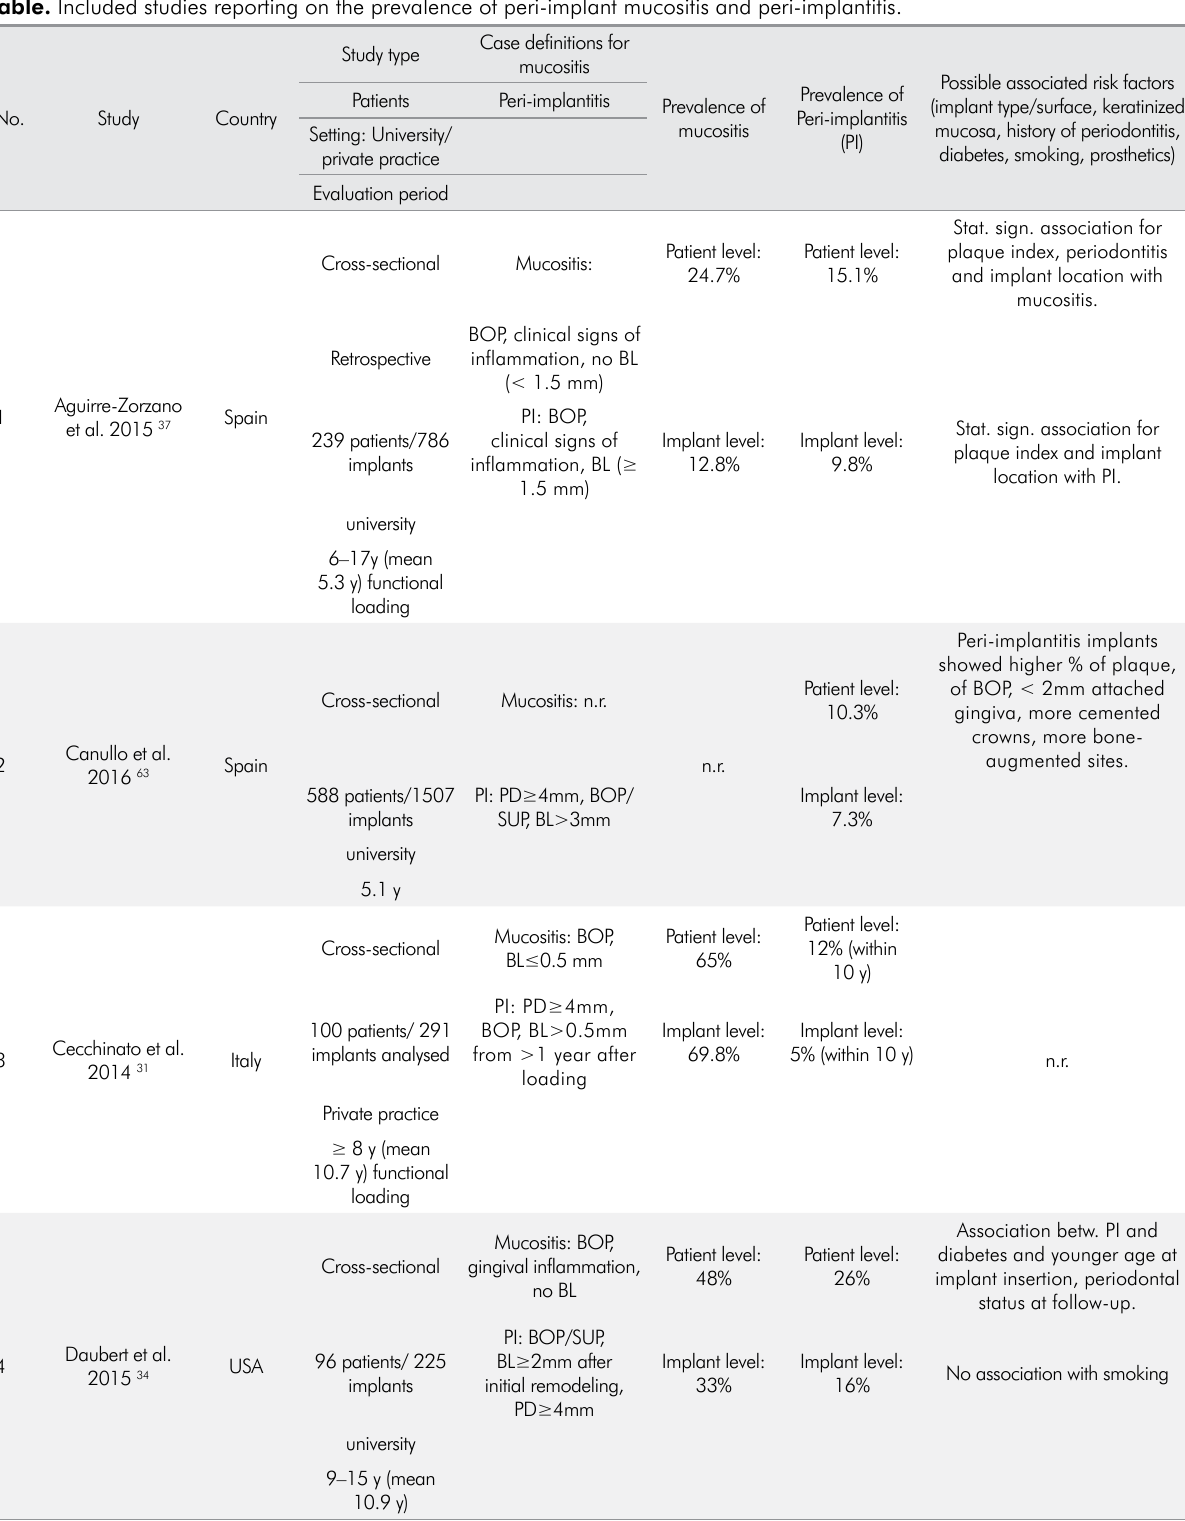
Table. Included studies reporting on the prevalence of peri-implant mucositis and peri-implantitis.